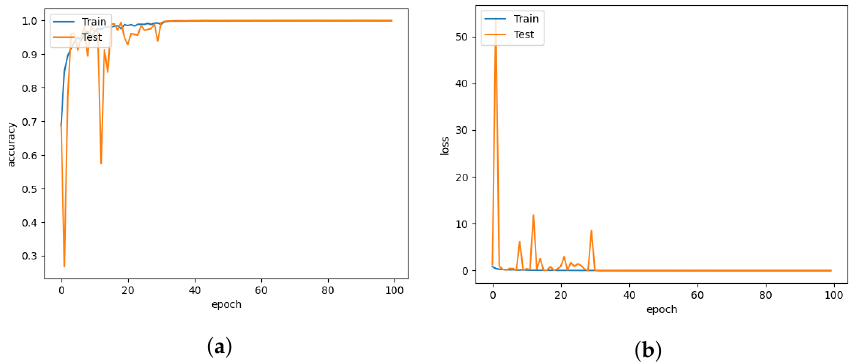
Figure 11. Xception for learning rate = 0.001. ( a ) Model accuracy. ( b ) Model